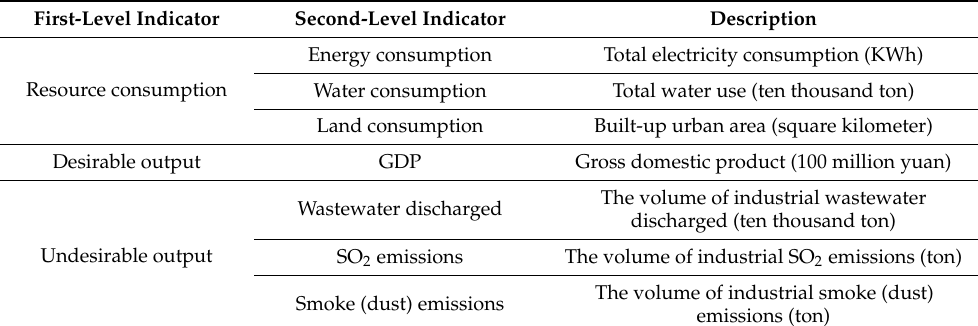
Table 1. Super-efficiency SBM model input/output